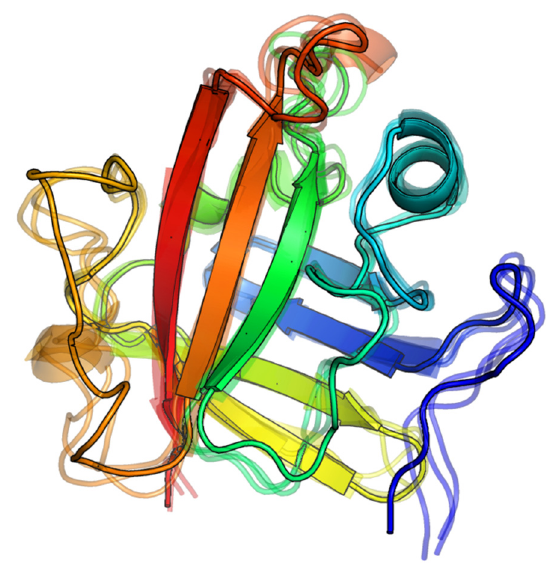
Figure 7. The initial and three final geometries of independent replicas of 10 ns MD of the apo form of SrtA.